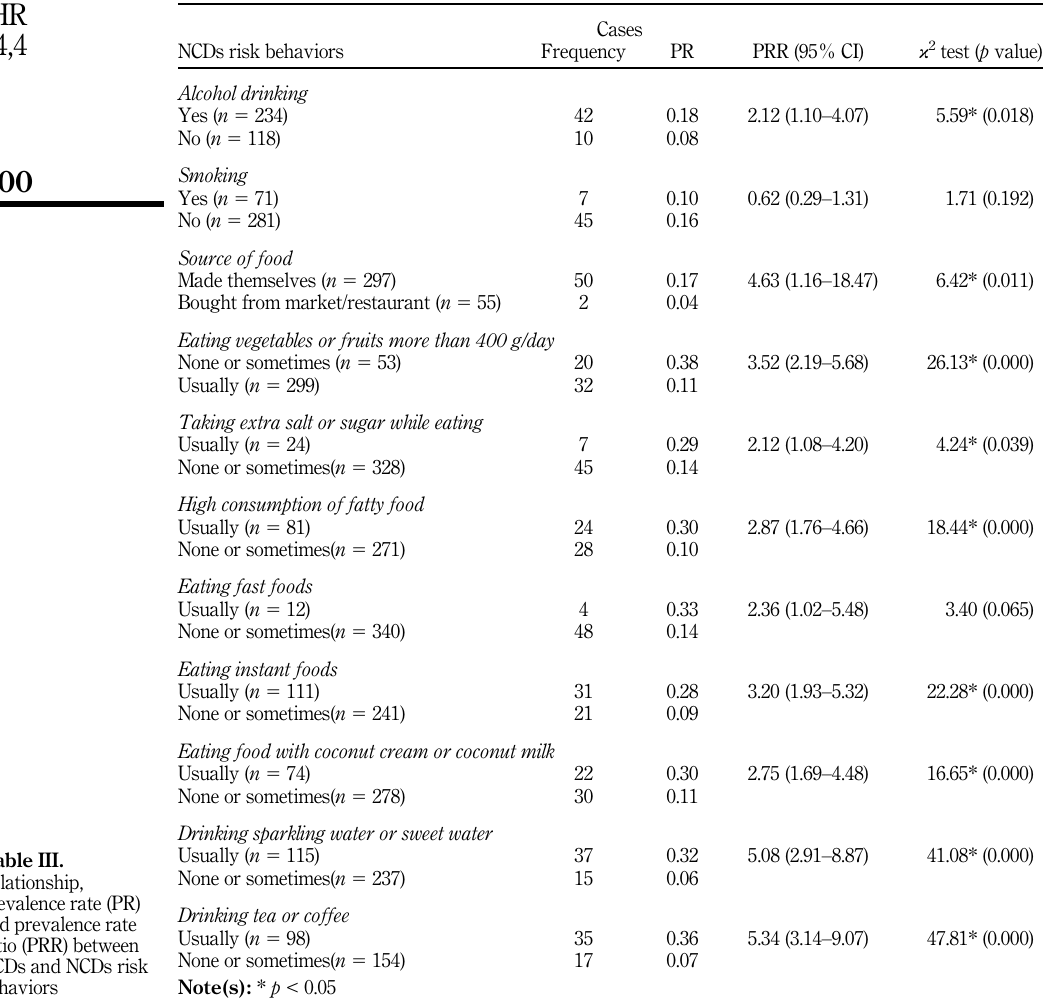
prevalence rate (PR) and prevalence rate ratio (PRR) between NCDs and NCDs risk